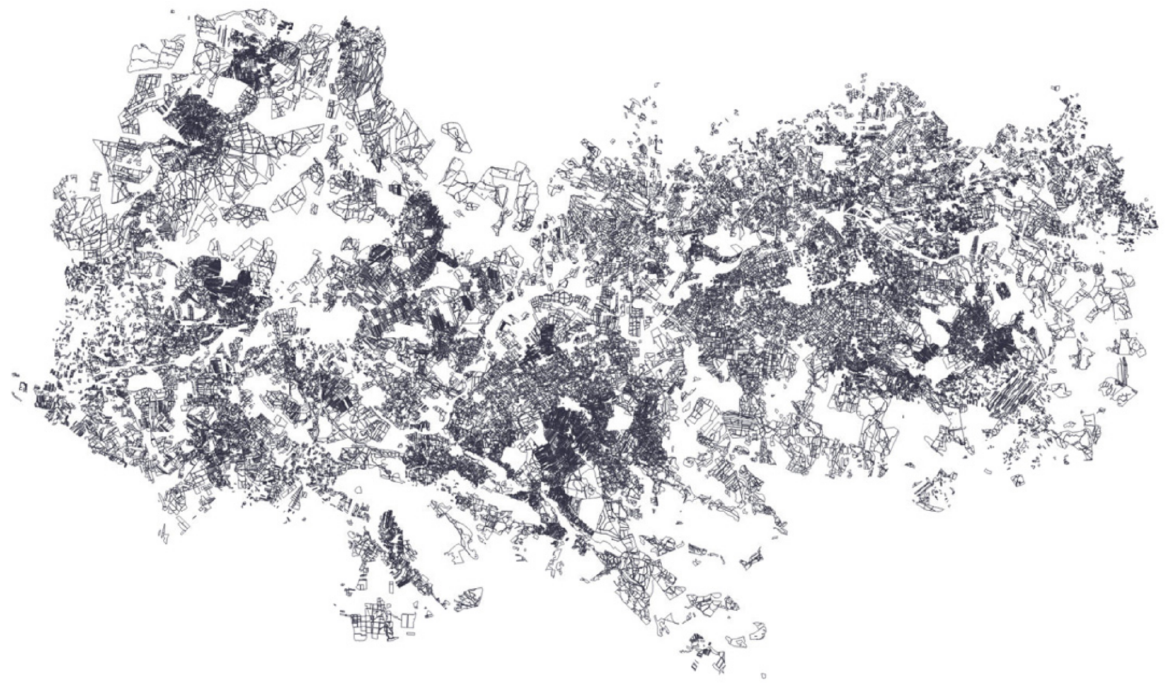
Figure 6. Geographical representation of the geolocation of the study plots. Region of M é rida (38 ◦ 54 (cid:48) N 6 ◦ 20 (cid:48) W) and Don Benito (38 ◦ 57 (cid:48) 16.3” N 5 ◦ 51 (cid:48) 42.2” W),